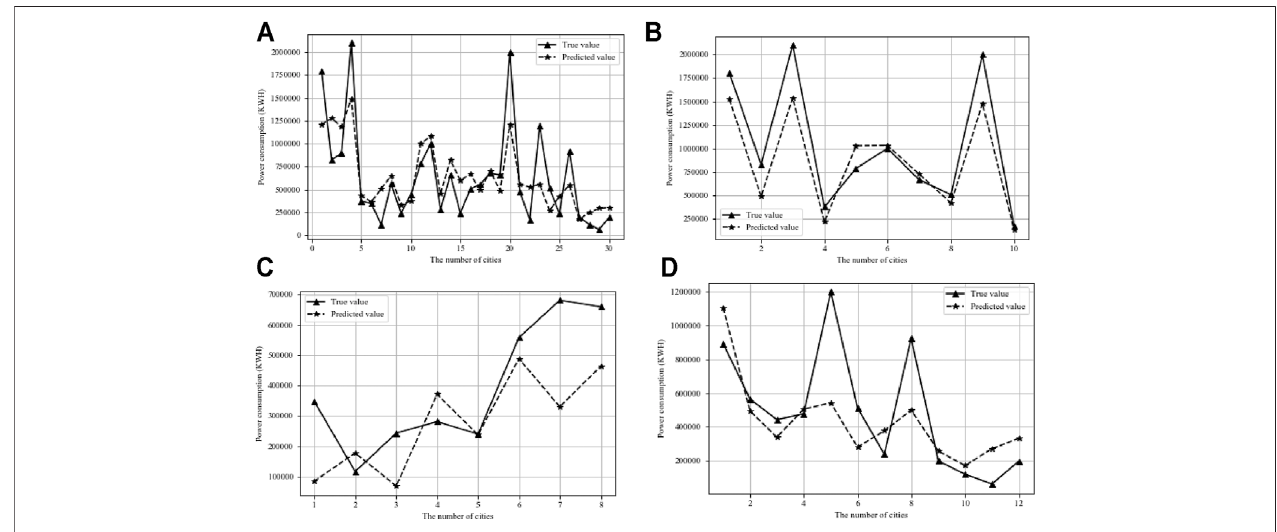
FIGURE 3 | Linear forecast results for national urban household electricity consumption.